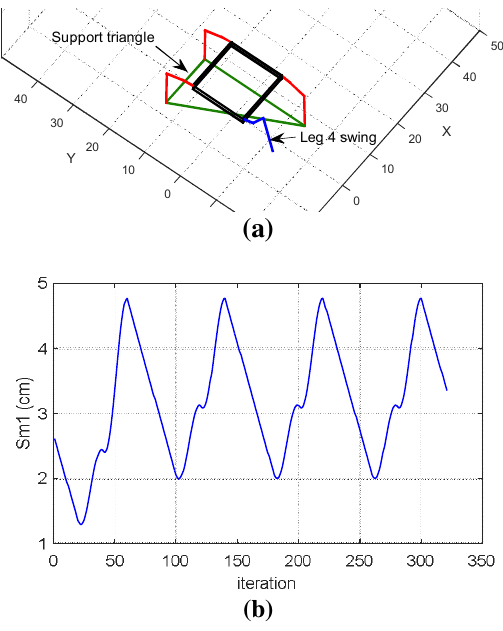
Fig. 12. Showing (a) Leg 4 in swinging phase (b) The stability margin (cm) when leg4 is vw >